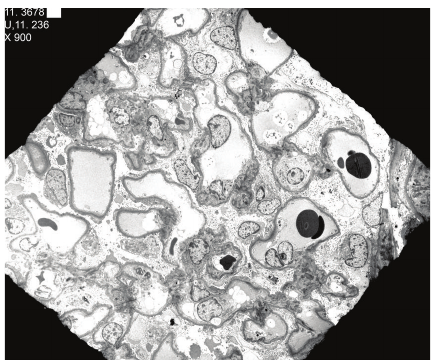
Figure 1: Electron micrograph ( × 900).